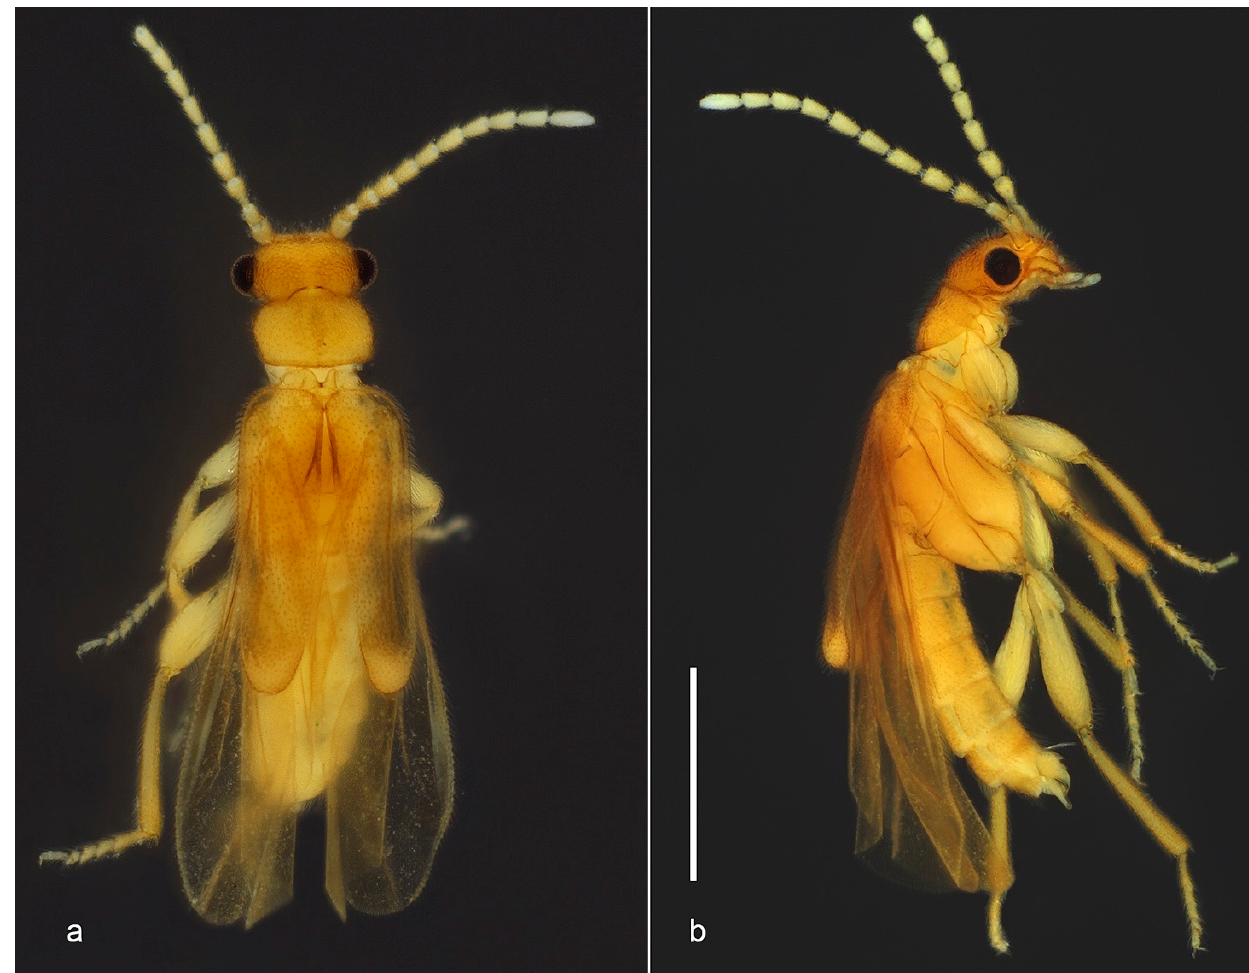
Figure 1. Jurasai miraculum sp. nov., habitus. ( a ) Dorsal view; ( b ) lateral view. Scale bar = 1.0 mm.